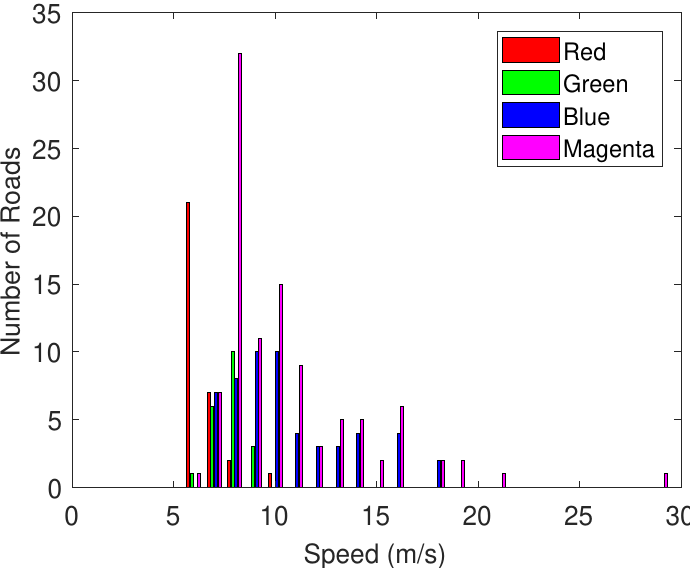
Figure 12. Histogram of link speeds for the time period = 6 in the case of the density